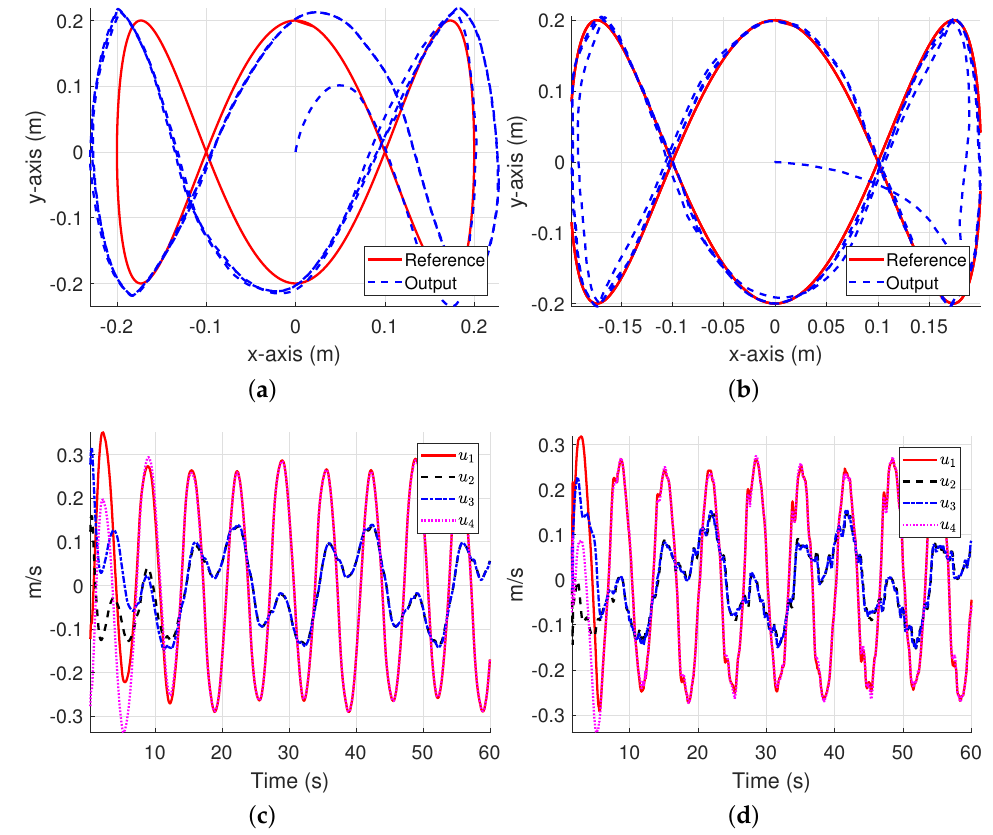
Figure 19. Experimental results for the sinusoidal trajectory. ( a ) Trajectory following for PID. ( b ) Trajectory following for EKF-SNPID. ( c ) Velocity control signal of PID. ( d ) Velocity control signal of EFK-PIDNN.